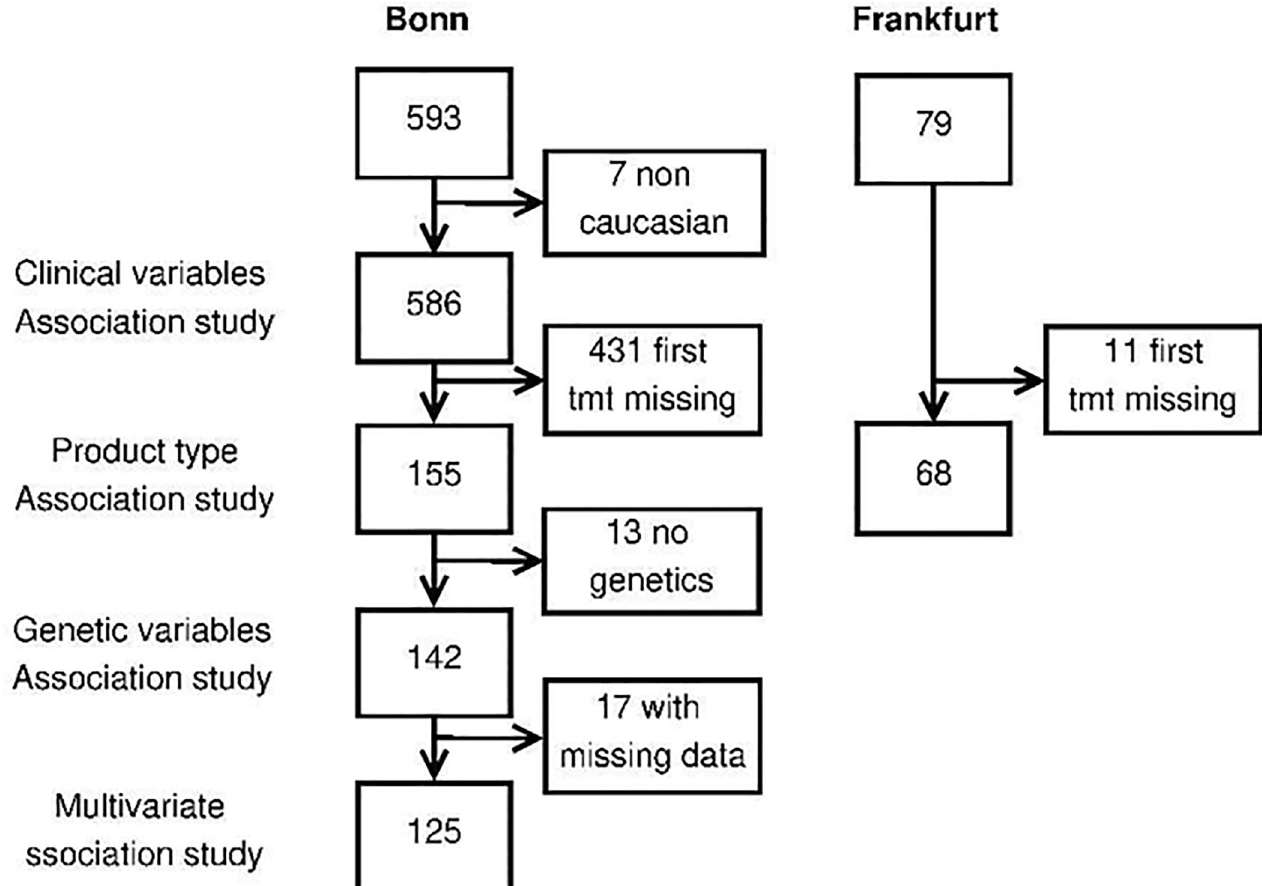
Fig 1. Patient inclusion flow chart per site in association studies.